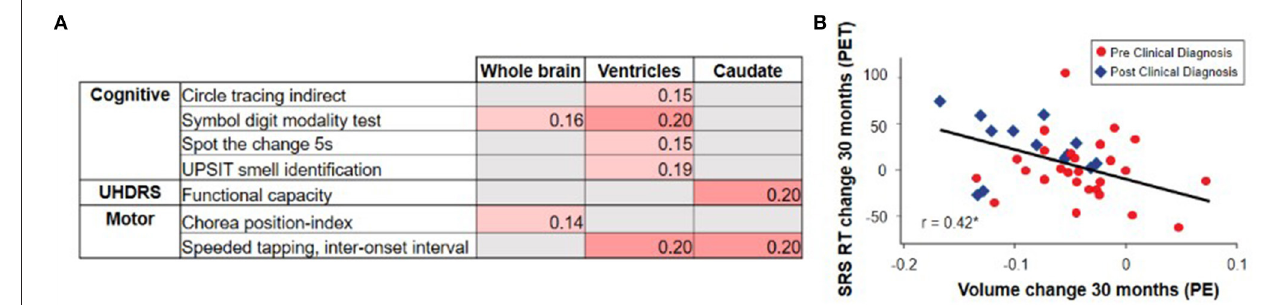
FIGURE 6 | The TRACK-HD study showed (A) relatively weak and selective correlations between changes in vMRI metrics and changes in clinical outcomes over a 12-month interval (2). Partial correlations across participants with and without a clinical motor diagnosis, controlled for age, sex, education, and study site, nominally significant at p < 0.05 are shown. The IMAGE-HD study showed (B) that 30-month change in caudate volume is significantly correlated with 30-month change in reaction time (RT) during performance of a cognitive task that required shifting response set (SRS) (20) (i.e., greater volume loss was associated with longer reaction times